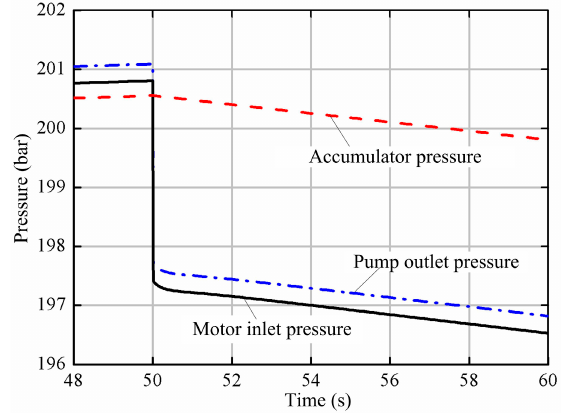
Figure 20. Pump outlet, accumulator, and motor inlet pressure.